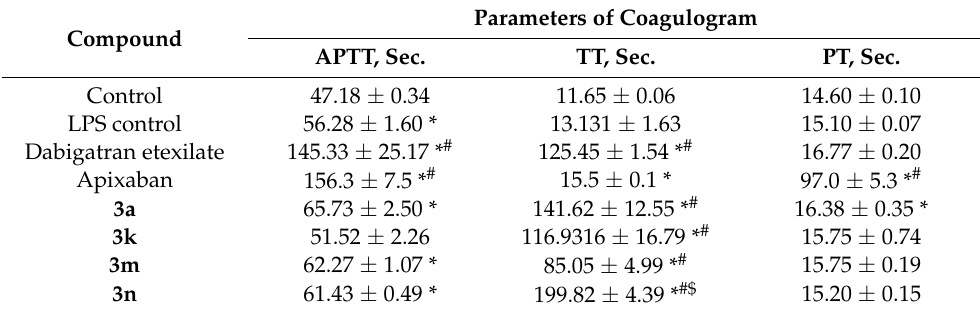
Table 4. Effect of compounds on the parameters of coagulogram of rabbit blood treated with LPS in vitro in a concentration of 100 µ M (M ± m, n = 5).